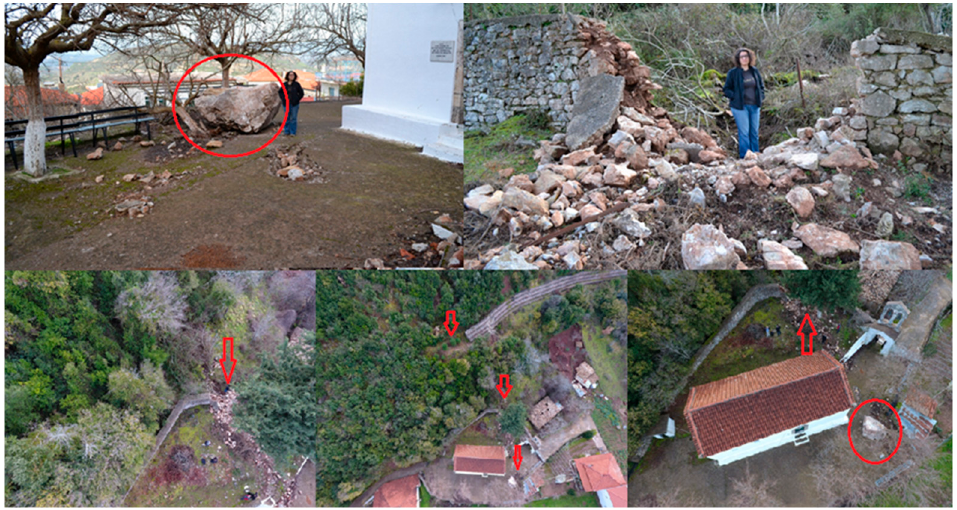
Figure 9. Pictures taken from Platiana region after rockfall event.